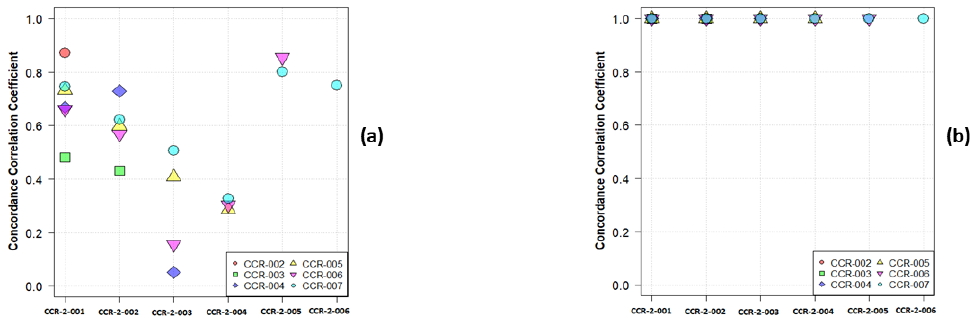
Figure 2. The pairwise CCC values for the first order mean values across 7 scans for ( a ) a single layer of the phantom (ABS-040), ( b ) all the layers.